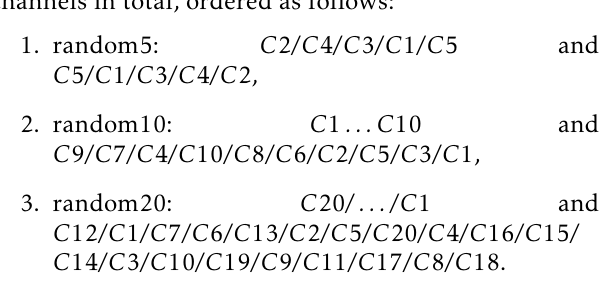
Figure 8. Inter-rendezvous time variance (cid:27) 2 different channel ranking